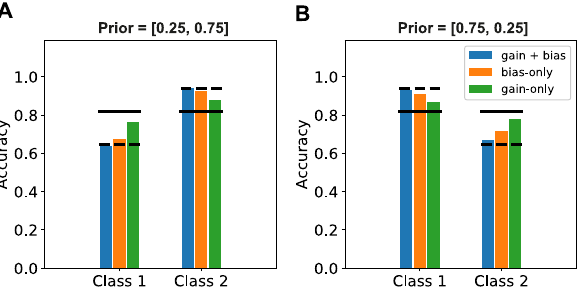
Figure 7. Cue influence mainly through bias. The accuracy for both classes was determined for the cued priors ( A : [0.25, 0.75] and B : [0.75,0.25]). (A,B) The class with the highest prior probability according to the cue, was decoded much more accurately when the cue influenced both the gain and the bias (blue bars), closely resembling the accuracy of the optimal Bayesian model (dashed line). Turning off the cue effect on the gain diminished this effect only slightly (orange bars). Turning off the cue effect on the bias diminished this effect much more, almost completely removing any effect of the cued prior (green bars), making the accuracy more similar to the accuracy of a Bayesian model that only accounts for the likelihood (solid